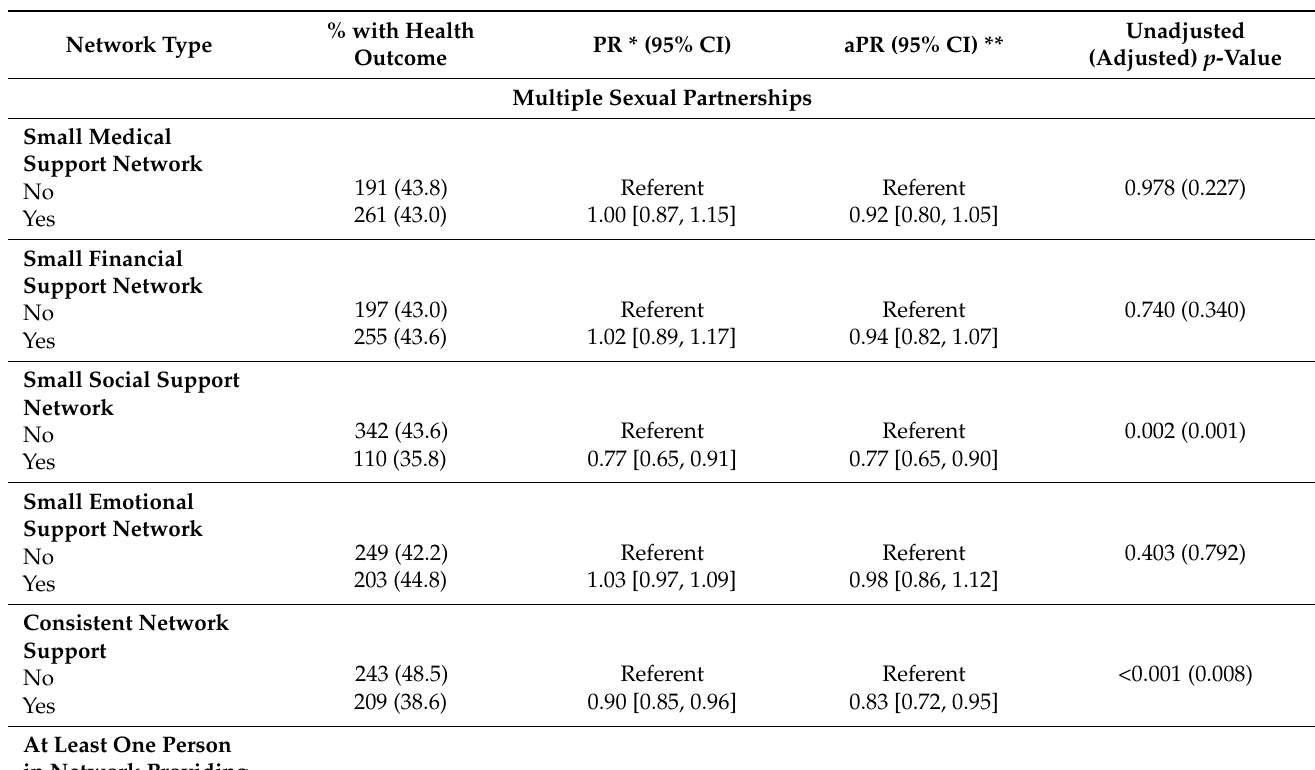
Table 3. Associations between Types of Networks and Health Outcomes at 12 Months Follow Up (N =